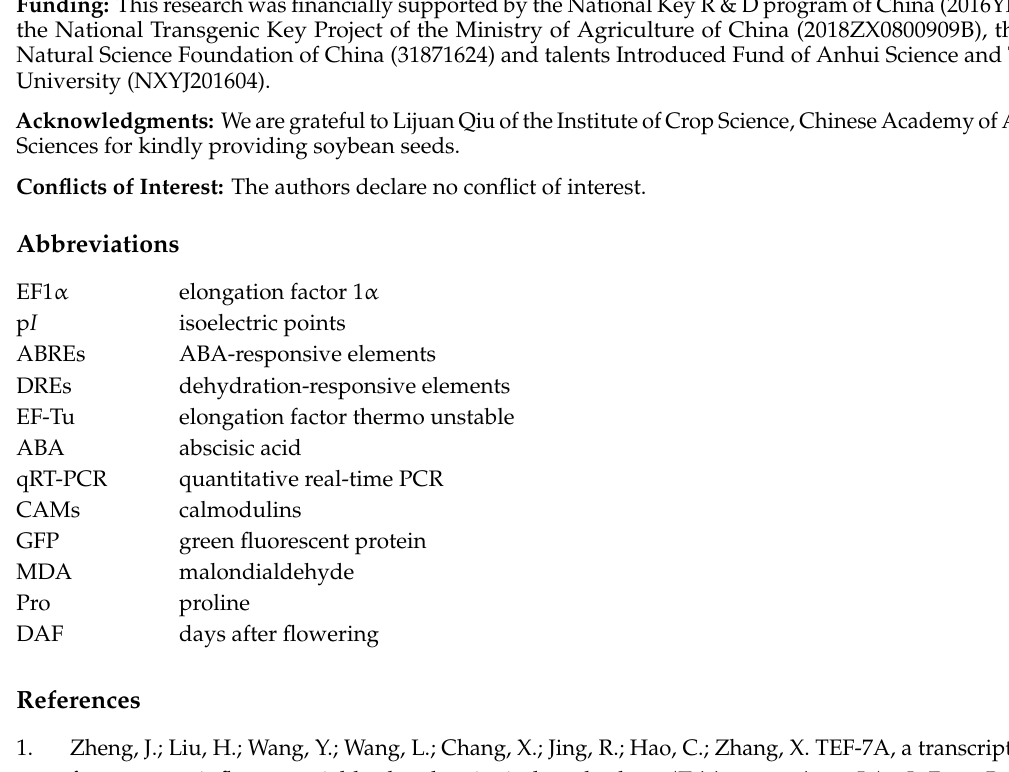
Figure S1; qRT-PCR analyses of GmEF4 expression in GmEF4 -OE and EV-control transgenic soybean hairy